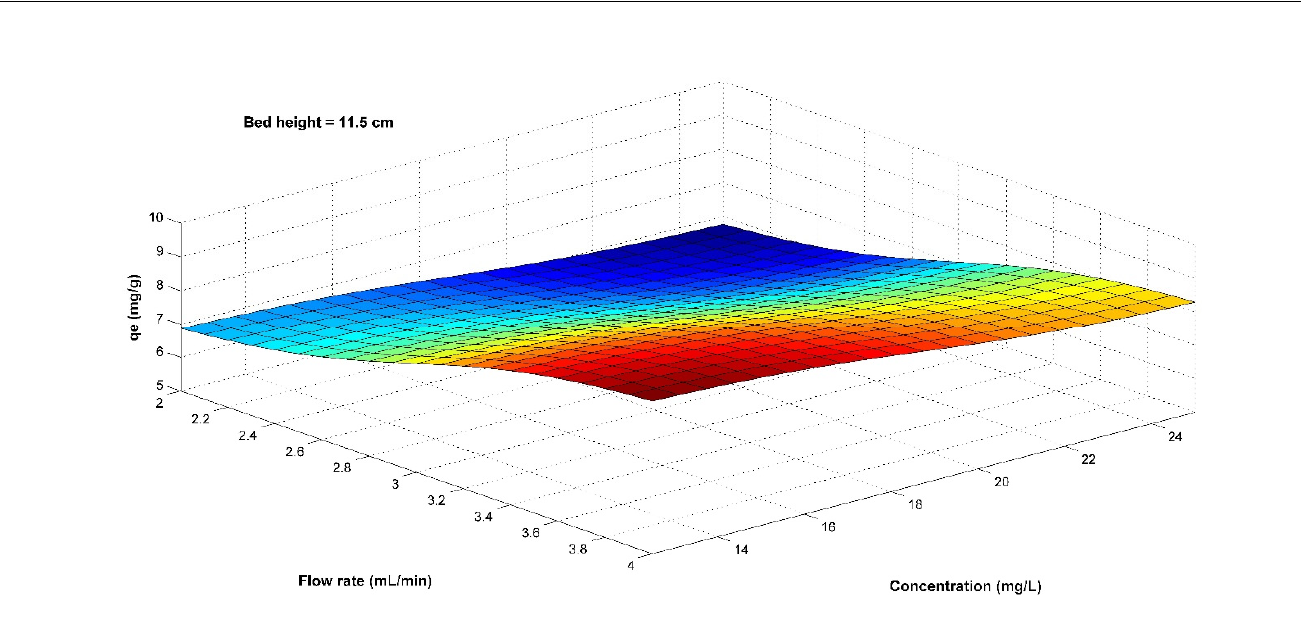
Figure 3. Surface graphs for cobalt biosorption capacity ( q e ): ( a ) inlet concentration vs. bed height at constant feed-flow rate, ( b ) feed-flow rate vs. bed height at constant inlet concentration, ( c ) inlet concentration vs. feed-flow rate at constant bed height.